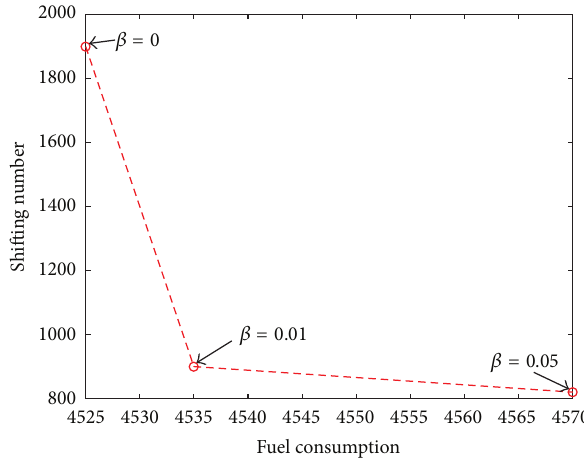
Figure 7: Gear-shifting number versus fuel